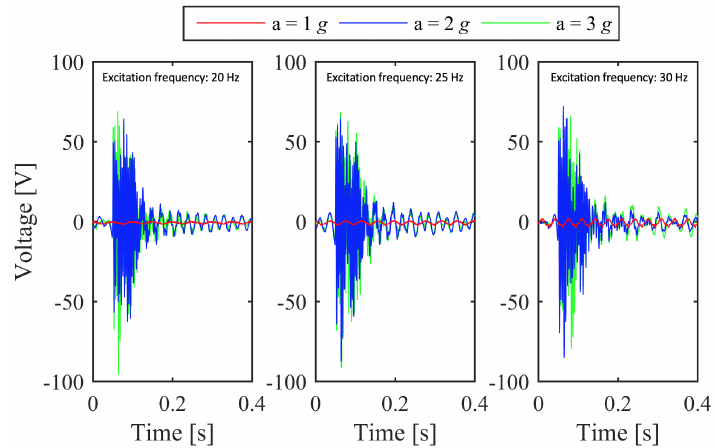
Figure 16. Open-circuit output voltage obtained during the STB test with sinusoidal excitation at frequencies of 20, 25, and 30 Hz and peak amplitudes of 1, 2, and 3